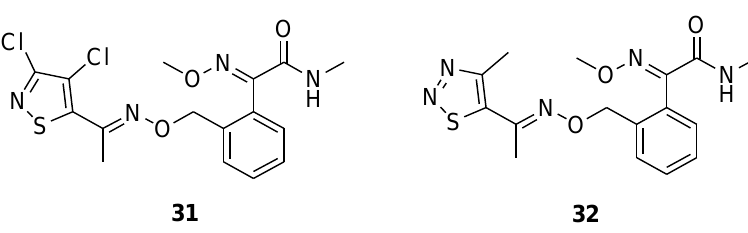
Figure 8. Structure of 3,4-dichloroisothiazole and 1,2,3-thiadiazole-containing strobilurins.